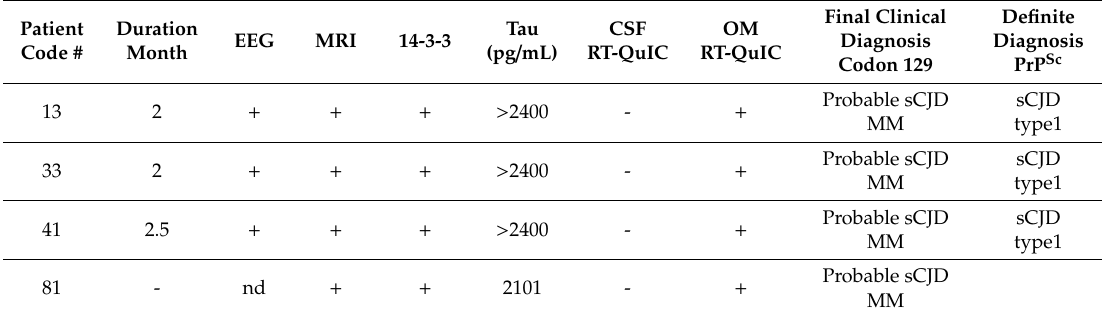
Table 5. Probable and definite sCJD with negative CSF RT-QuIC testing.